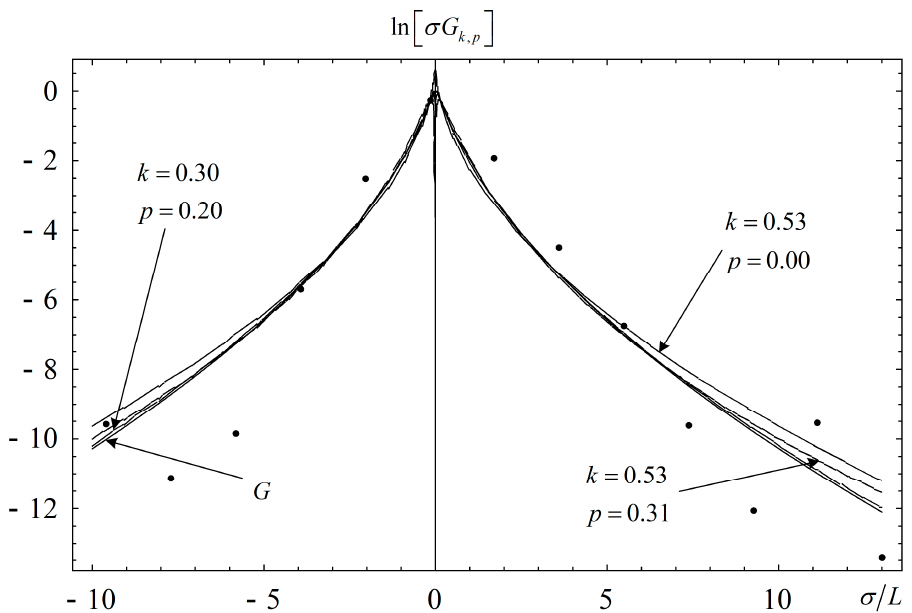
Figure 3. Measurement probability altitude deviations of aircraft (dots) showing improving fits for (1) the generalized error distribution with exponent k = 0.53 (dotted line); (2) the combined Gamma and generalized error distribution with exponent k = 0.53 for the exponential and exponent p = 0.31 for the power (dashed line); (3) item with k = 0.3 and p = 2.0 (solid line); and (4) a probability distribution G combining two of the preceding with suitable weight. The simplest case (1) is sufficient to model the tail of the probability distribution.